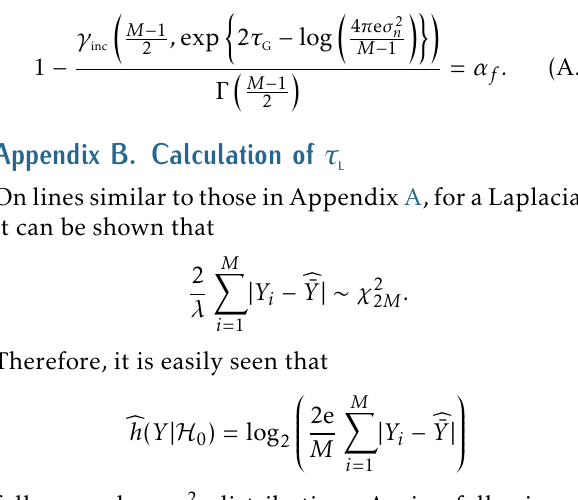
using (C.7) and from G